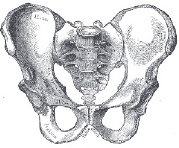
Figure 16. Human pelvic bones. Source: Wikipedia.